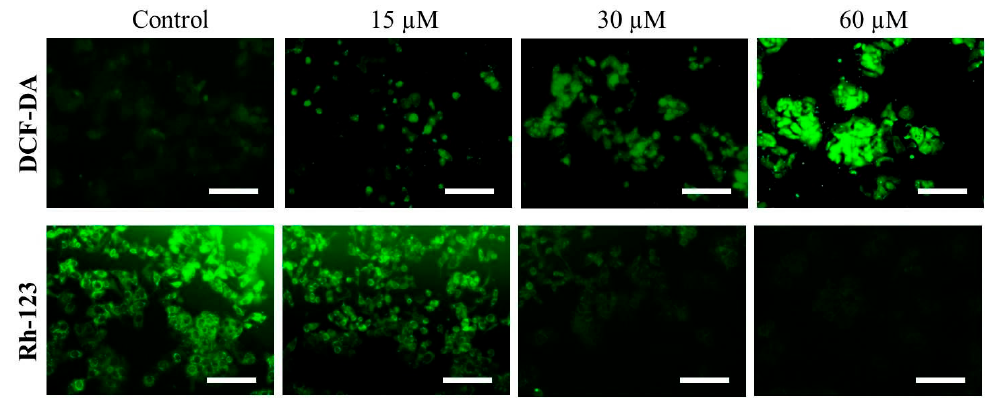
Figure 5. Efficacy of Far-C in augmenting the intracellular level of ROS and dissipation of ∆Ψ m in a dose-dependent trend. Scale bar = 100 µm.